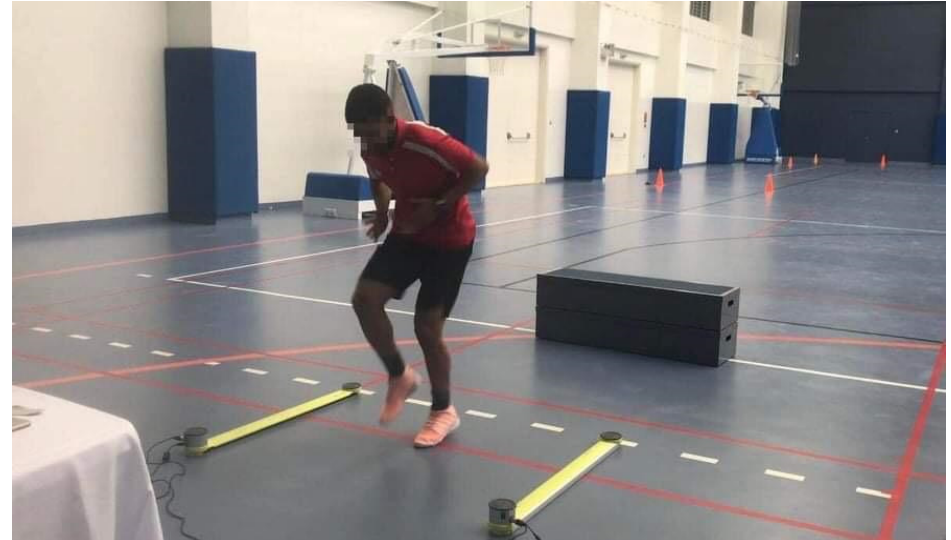
Figure 2. TAP test. In standing up position, the players are asked to tape the feet as quickly as possible on the ground with two alternating limbs for 4 s using Optojump Next (Microgate Next, Bolzano, Italy).